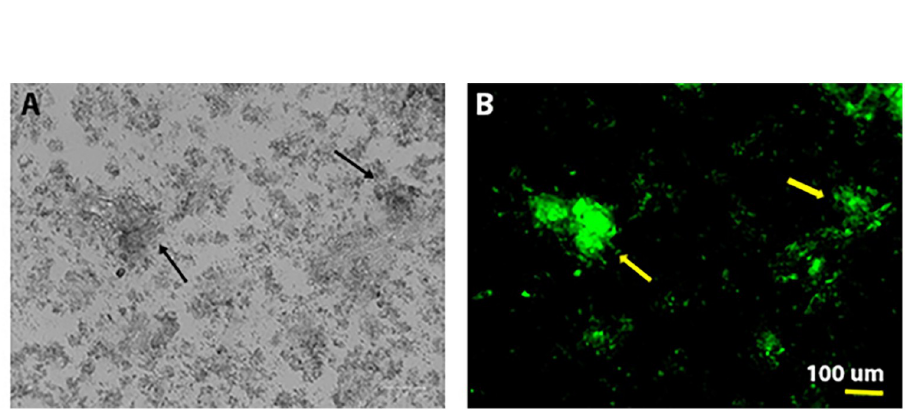
Fig 8. pNPs containing covalently attached quercetin exhibit binding to clusters (indicated by arrows) within calcified smooth muscle cell cultures that were visible in both brightfield (A) and fluorescence (B) images.